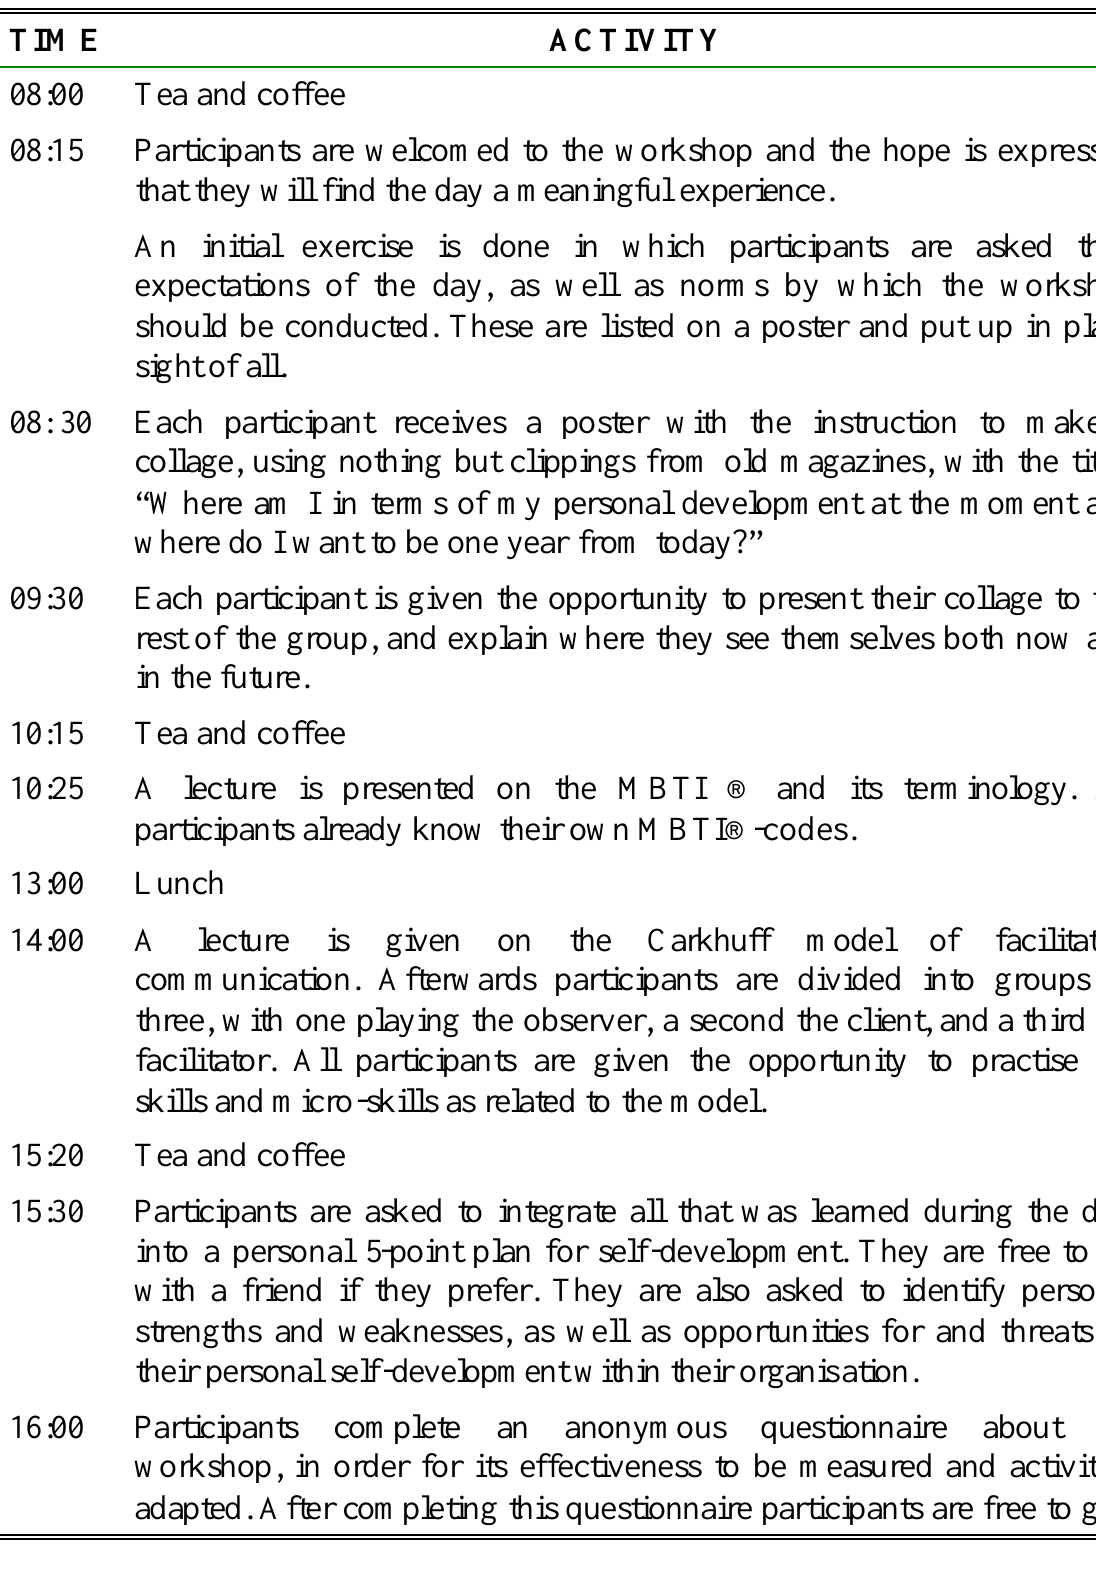
Workshop programme